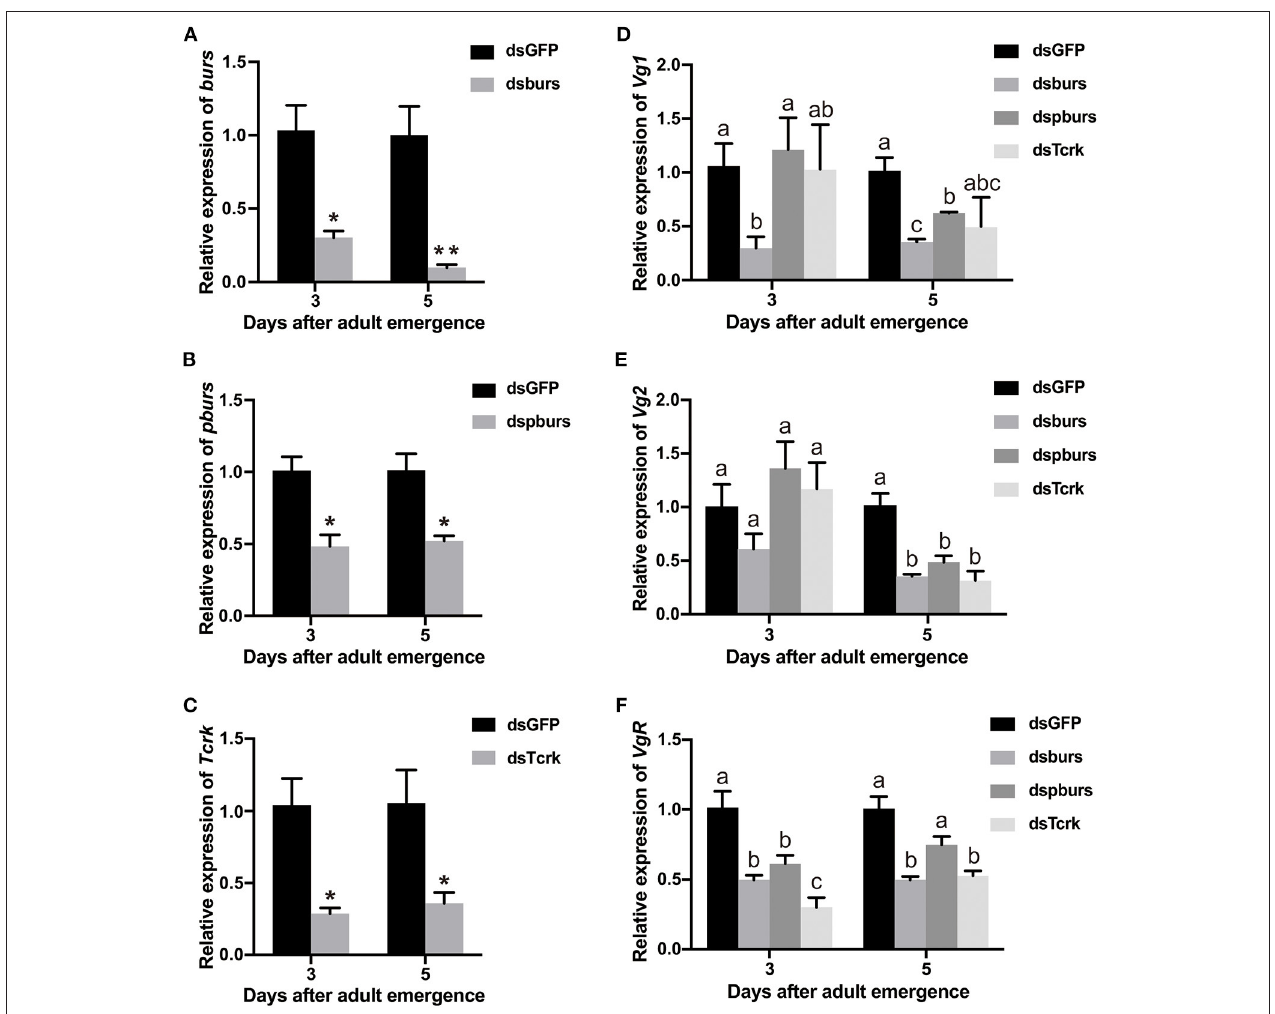
FIGURE 2 | The efficiency of burs, pburs, or Tcrk RNA interference (RNAi) and their effects on the expression of Vg1 , Vg2 , and VgR . (A–C) Relative expression levels of burs , pbur , or Tcrk in 3- and 5-day females after dsGFP, dsburs, dspburs, or dsTcrk treatments. (D–F) Relative expression levels of Vg1 , Vg2 , and VgR in 3- and 5-day females after dsGFP, dsburs, dspburs, or dsTcrk treatments. The asterisks above bars indicate significant differences between the treatment and the corresponding control, * p < 0.05, ** p < 0.01 by t -test. Different letters on the bars indicate the means ± SEM, which are significantly different ( p < 0.05) among treatments by